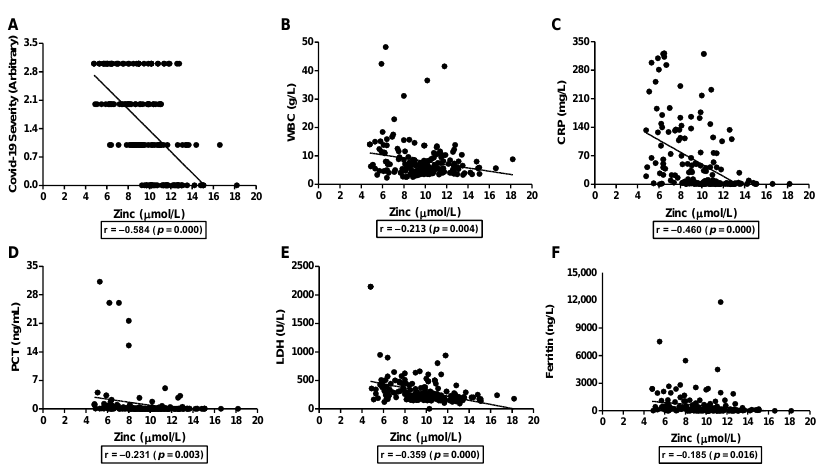
Figure 2. Correlation between serum zinc and inflammatory markers in the COVID-19 patients. Serum zinc value from all the subjects (control and COVID-19 patients) was used to study the association with COVID-19 severity ( A ), WBC ( B ), CRP ( C ), PCT ( D ), LDH ( E ), and ferritin ( F ). Correlation was analyzed by Pearson correlation analysis.